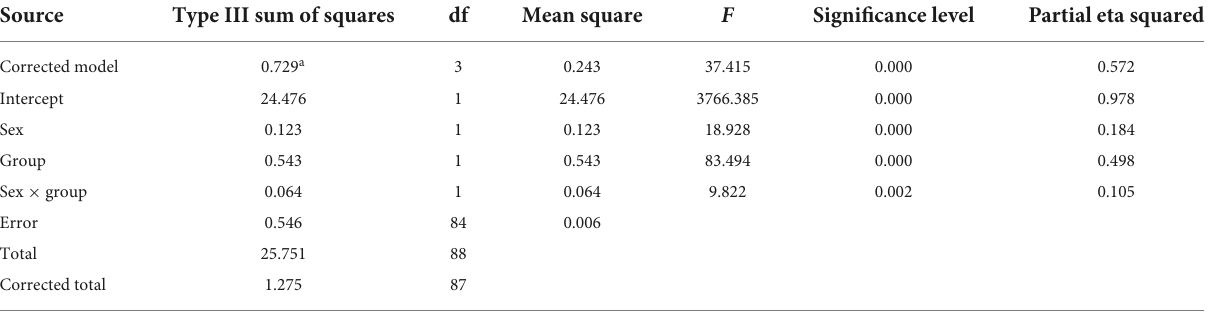
TABLE 2 Sex and group